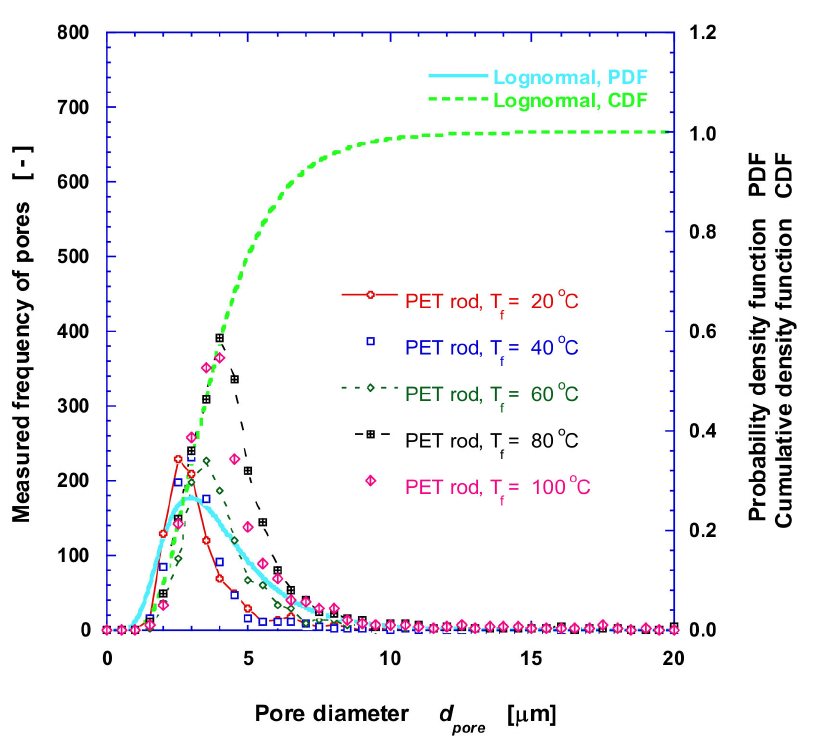
Figure 3. Size distribution of pores and probability density function for the CO 2 foamed PET– PEN structure (sorption at − 20 ◦ C for 24 h, post-foaming at 20–100 ◦ C for 3 min), measured from SEM